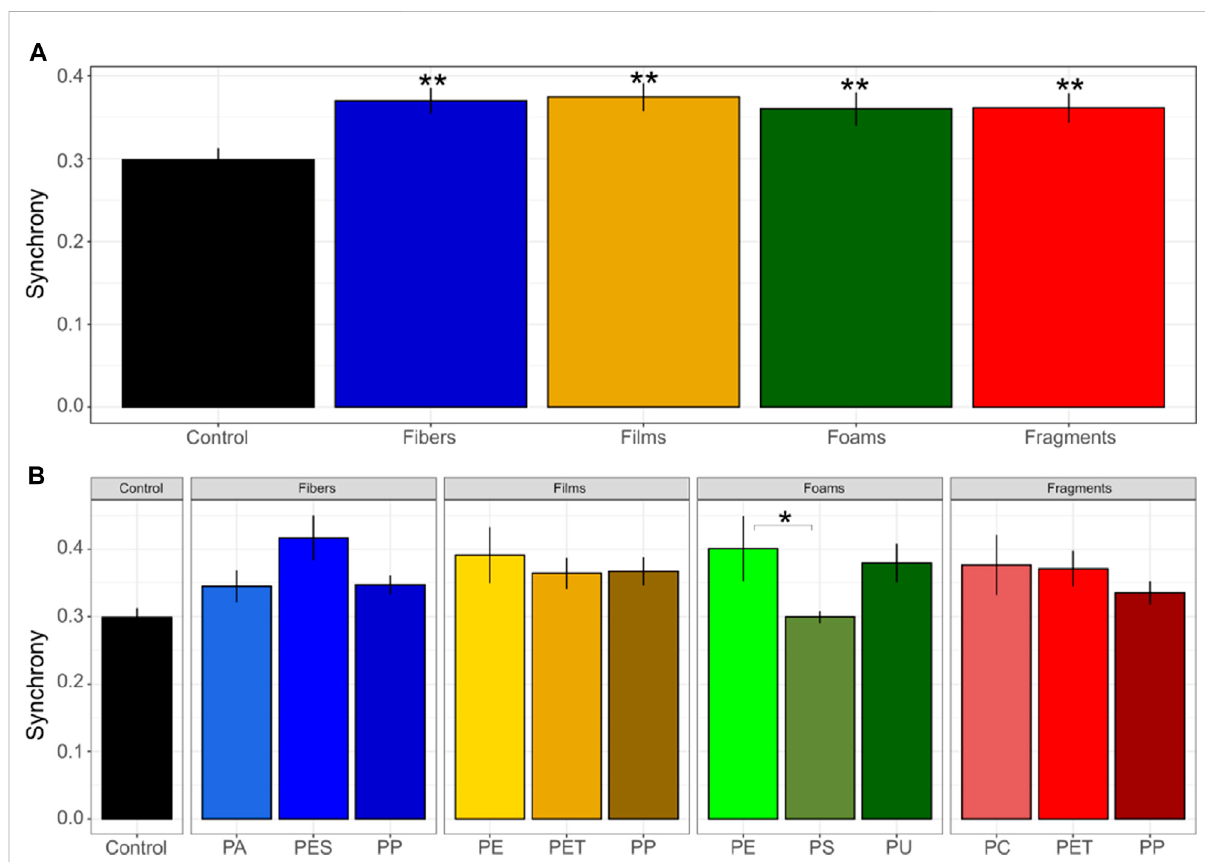
FIGURE 2 Germination synchrony of seeds of Daucus carota. Microplastic shape (A) and polymer types effects (B) on germination synchrony was evaluated. Differences between microplastic types and the control without microplastics) were tested using Dunnett test. Differences between polymer types within each microplastic shape were tested using Tukey test (** p < 0.05; * p < 0.1). Polymers: PA (polyamide), PES (polyester), PP (polypropylene), LDPE (low density polyethylene), PET (polyethylene terephthalate), PS (polystyrene), PU (polyurethane), and PC (polycarbonate). n = 10 for microplastics, n = 18 for control samples. The index of germination synchrony, indicates synchronization of germination (where the minimum is 0 and the maximum is